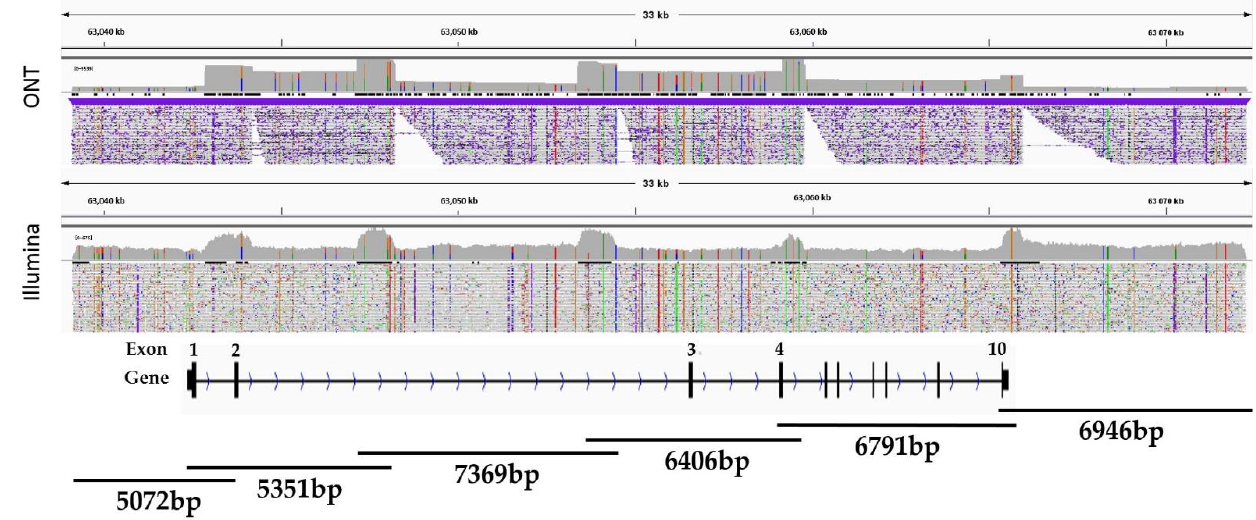
Figure 2. The coverage plot of the long PCR products (gene fragments) for the TPM1 gene of patient 1. Moreover, we observed greater variability in coverage between different amplicons than between the same amplicons from different DNA samples. This is probably due to both the length of the fragments and the GC% content or to some problems with sequenc- ing quality for certain gene